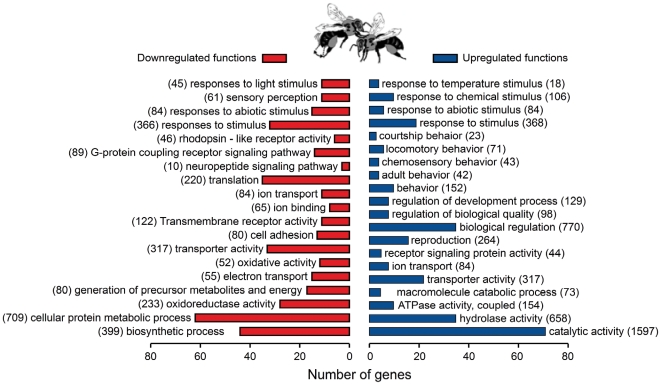
Functional analysis of genes associated with modulatory communication signal performance in honey bees.Gene Ontology molecular process and biological function categories that were significantly enriched in the gene sets down- and upregulated in V+ compared to V− bees (p<0.05). Categories are non-mutually exclusive. For each enriched category, the total number of genes with fly orthologs expressed on the microarray is given in parenthesis and the number of genes differentially expressed between V+ and V− bees is given by the x-axis.